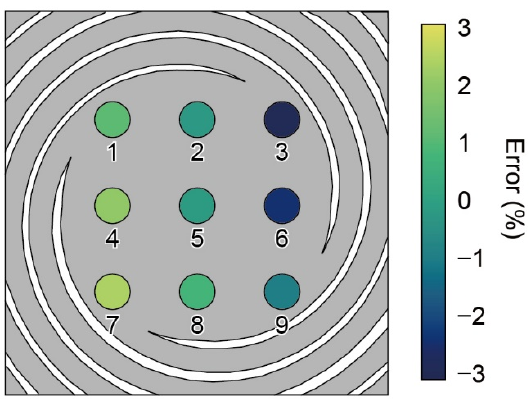
Figure 10. Distribution of the spring constant error of type (iv) in the experiment.